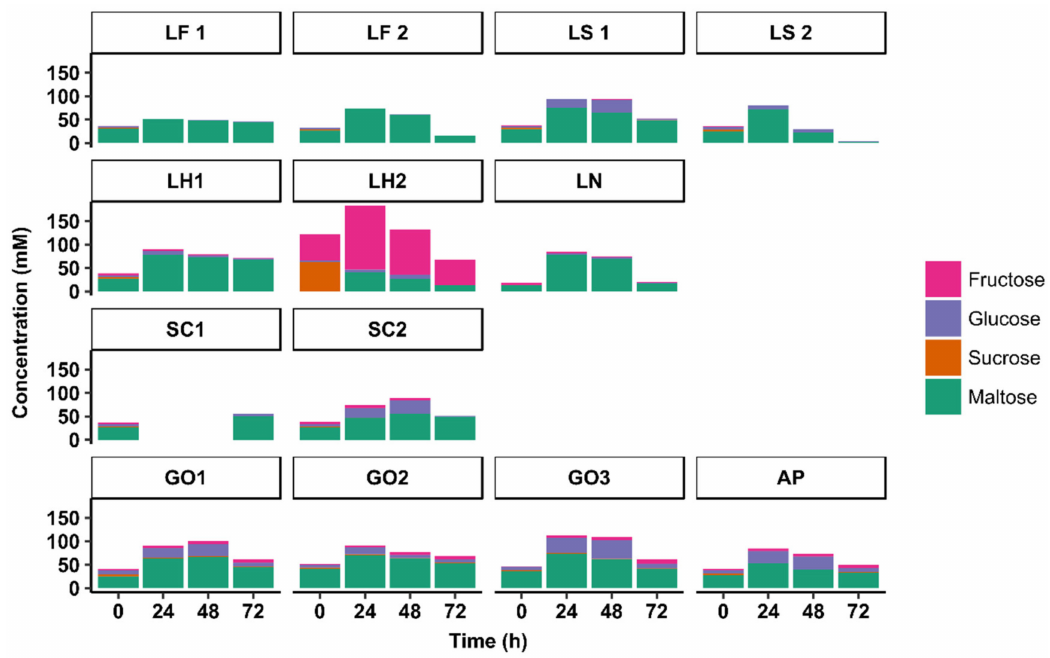
Figure 4. Carbohydrate concentrations during starter culture-initiated sourdough